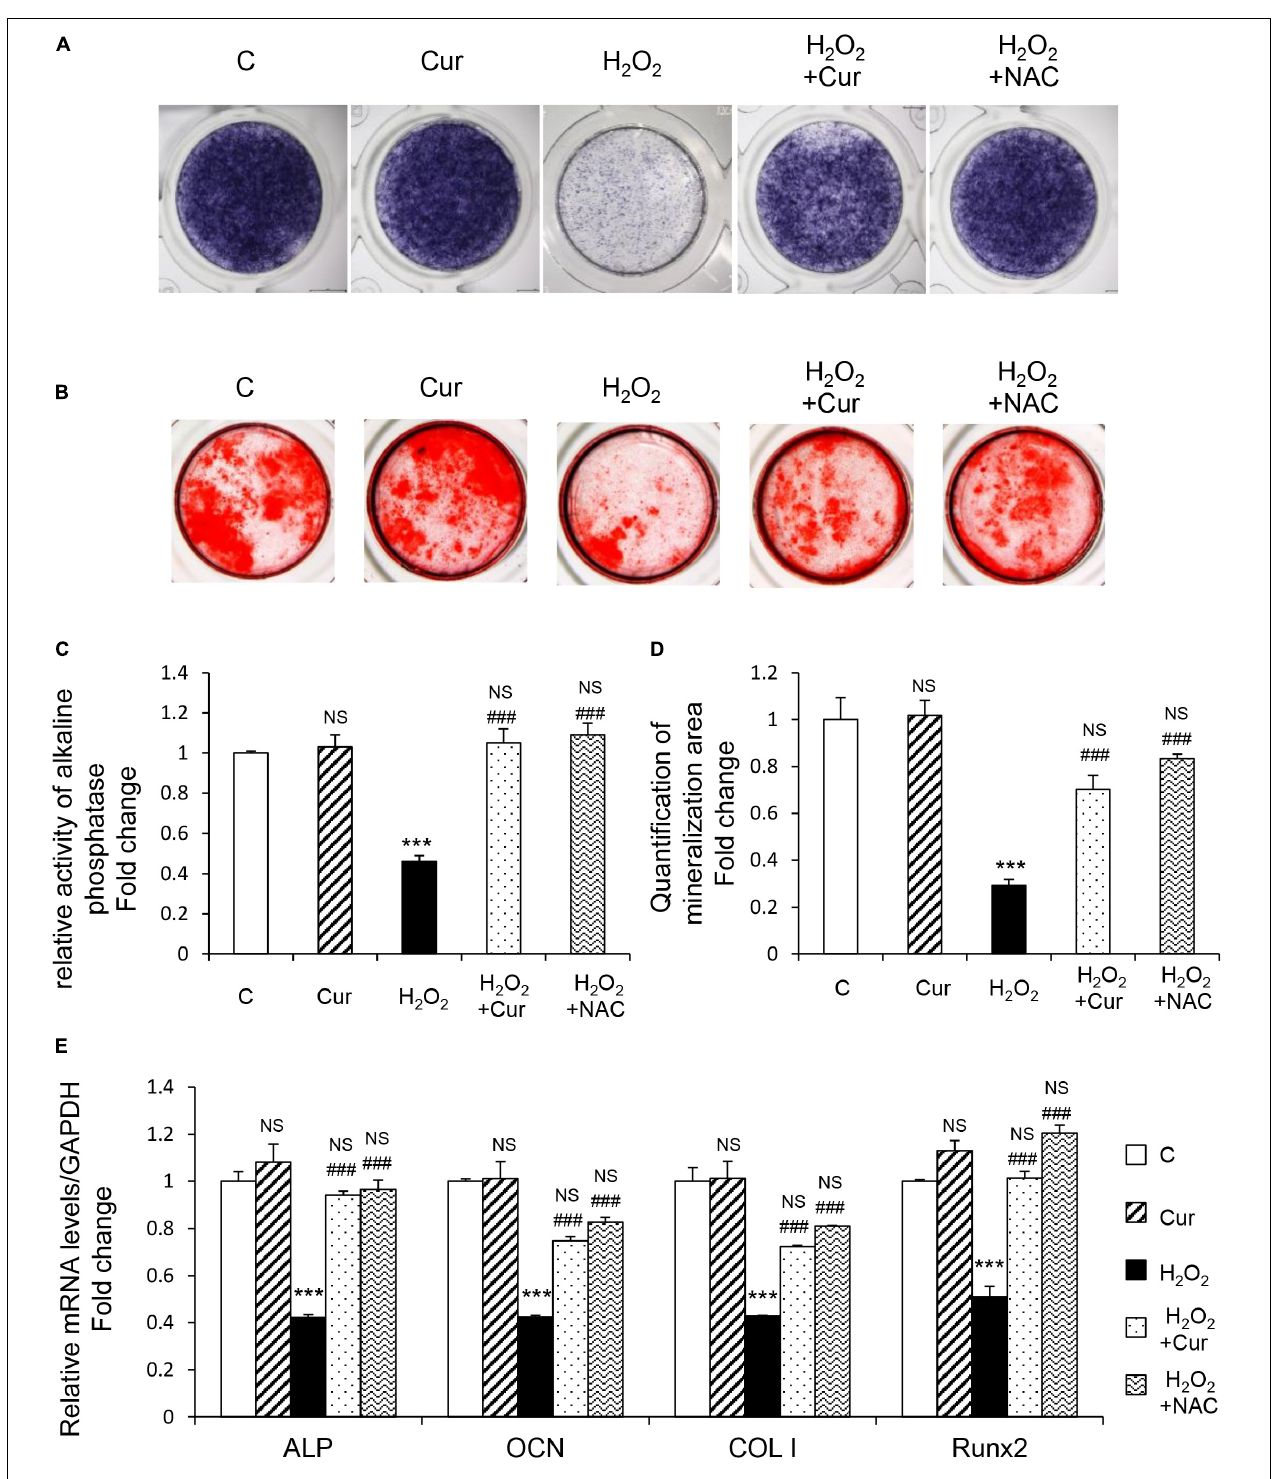
FIGURE 2 | Cur rescue H 2 O 2 induced osteoblast dysfunction. The MC3T3-E1 cells were treated in the osteogenesis differentiation medium with or without H 2 O 2 and Cur. (A) After the cells cultured for a week and they were subjected to ALP staining in the indicated treatment groups. (B) The alizarin red staining of MC3T3-E1 cells showed the mineralizing matrix after cultured for 2 weeks. (C) ALP activity tested in MC3T3-E1 cells as indicated groups. (D) Mineralization area was evaluated by tests. (E) When cultured for 3 days the expression of osteogenic marker genes were analyzed. Data are presented as the mean ± SD from at least three independent experiments. * p < 0.05, ** p < 0.01, *** p < 0.001, versus C group; NS, non-significantly different from C group. # p < 0.05, ## p < 0.01, ### p < 0.001, versus the H 2 O 2 group; ns, non-significantly different from H 2 O 2